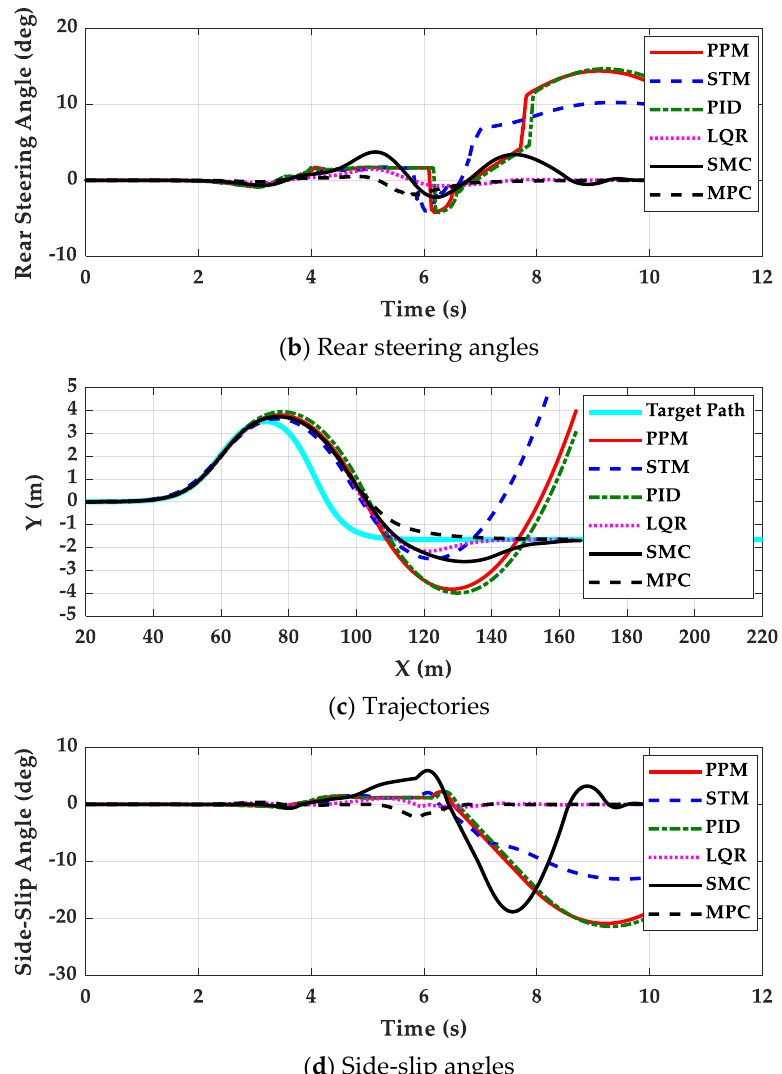
Figure 7. Simulation results of each controller for 4WS vehicle on low- µ road obtained from the second set of